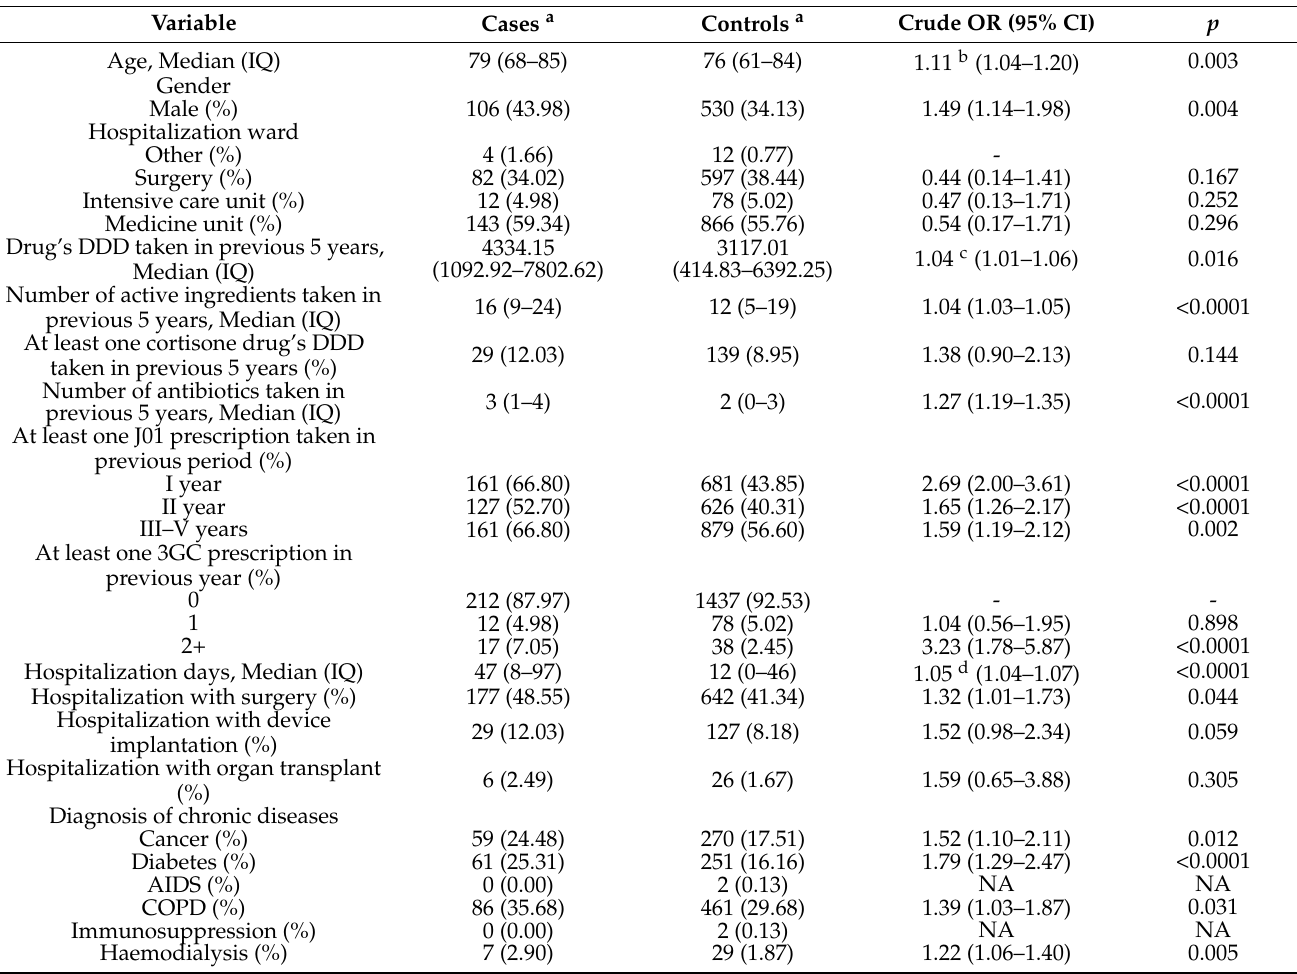
Figure 1. Distribution of included isolates. Others = vulvar, vaginal and perianal specimens, ascites and other abdominal fluid, pleural liquid, post-surgery drainage fluid. Within the study period, 241 cases and 1553 controls met the inclusion criteria, with a ratio of 6.44 controls per case. Patient characteristics are shown in Table 1. Table 1. Characteristics of 241 case patients infected/colonized with 3GC-resistant E. coli and 1553 matched control patients infected/colonized with 3GC-susceptible E. coli.